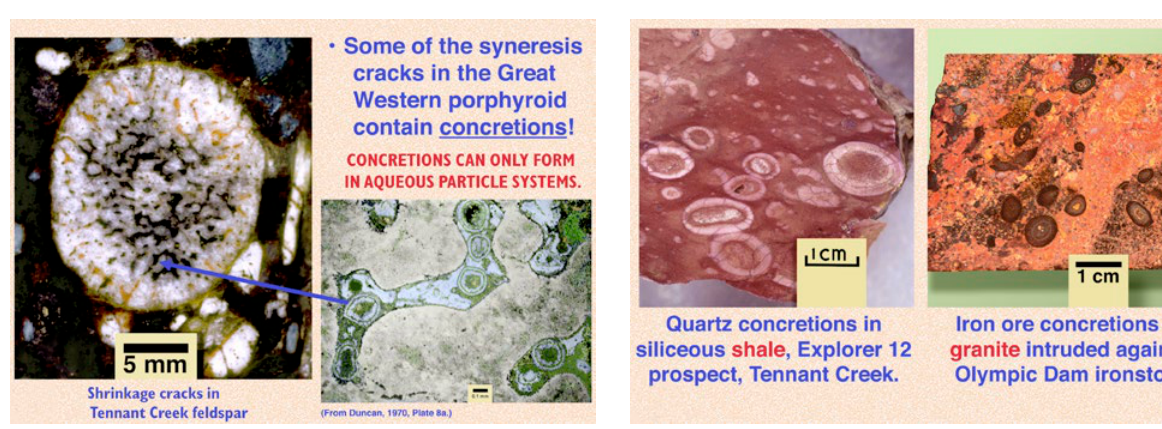
Figure 21. A diffusive gelatinous media is required for the forma- tion of oolites, orbicules and concretions. The occurrence of small poly-rimmed oolites in the shrinkage cracks of ovoidal feldspar from a coarse Tennant Creek porphyroid is positive evidence that the feldspar is a crystallised accretion.